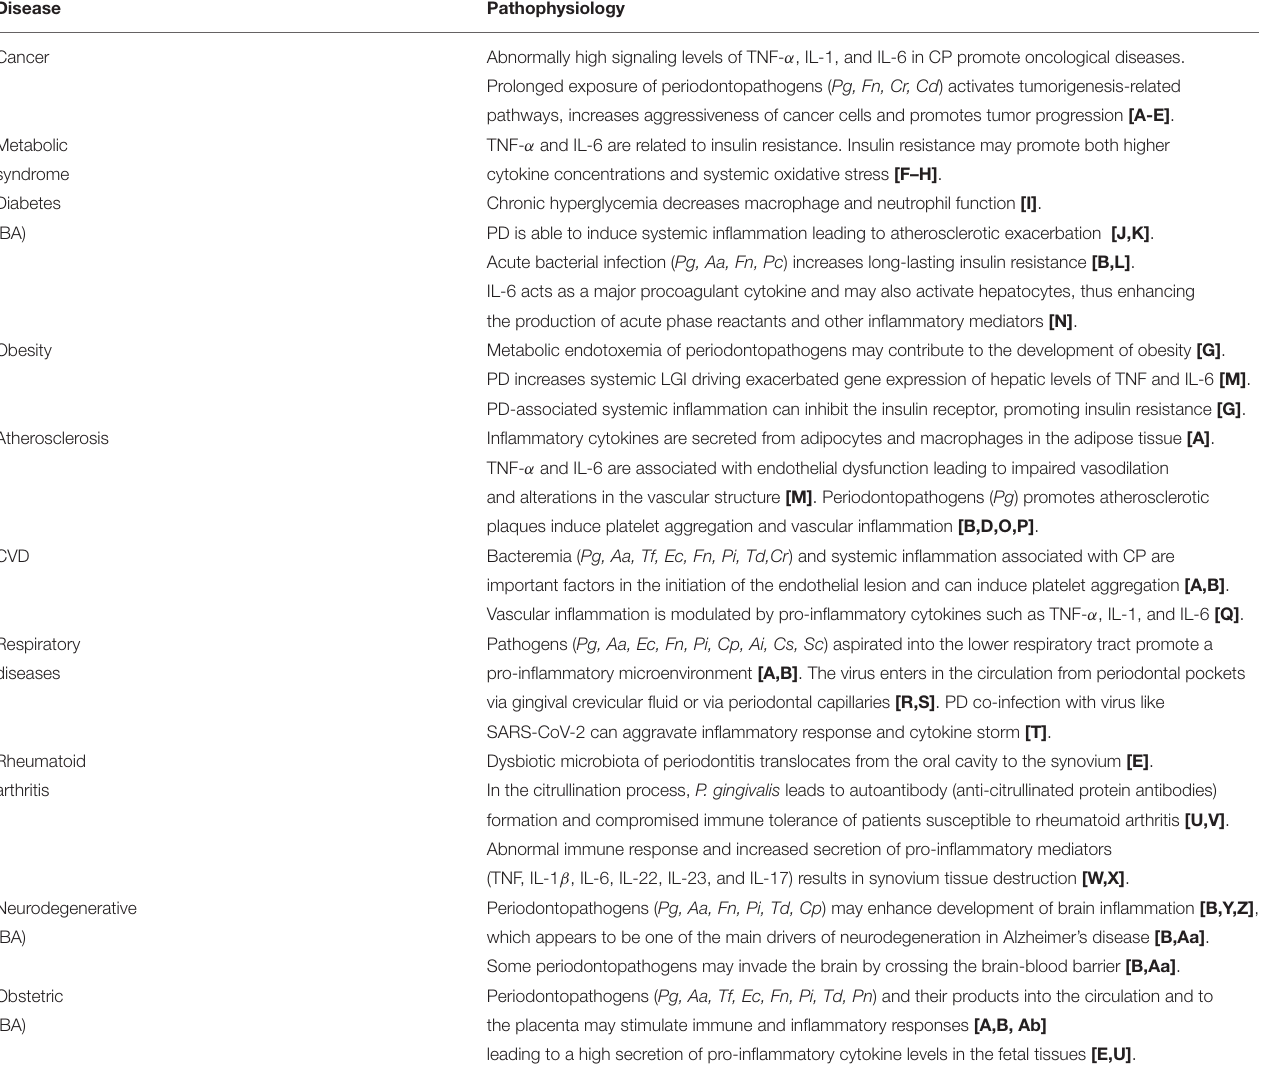
TABLE 3 | Brief overview of chronic diseases related with periodontal disease. Disease